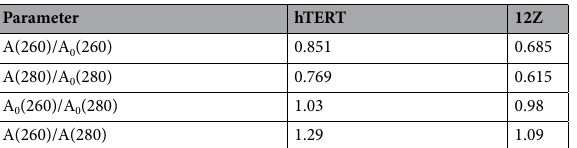
Table 3. Selected parameters calculated from absorption spectra of cell nuclei samples from hTERT and 12Z cell lines (A0=absorbance of samples from unaffected cells; A=absorbance of samples from cells treated with complex).